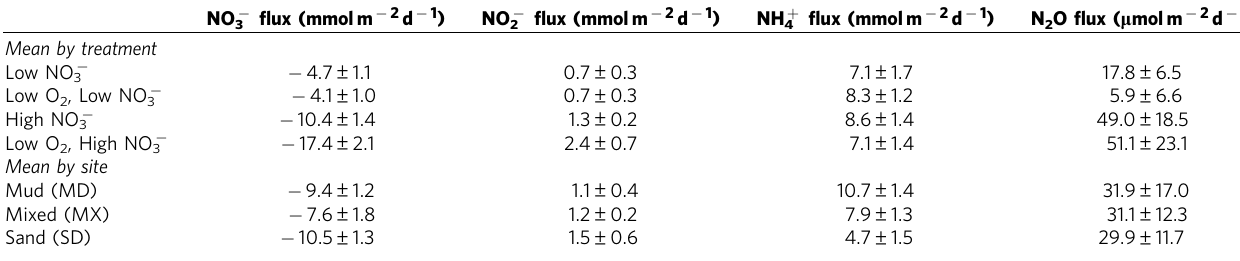
Table 1 | Steady state mass fluxes of measured nitrogen species.